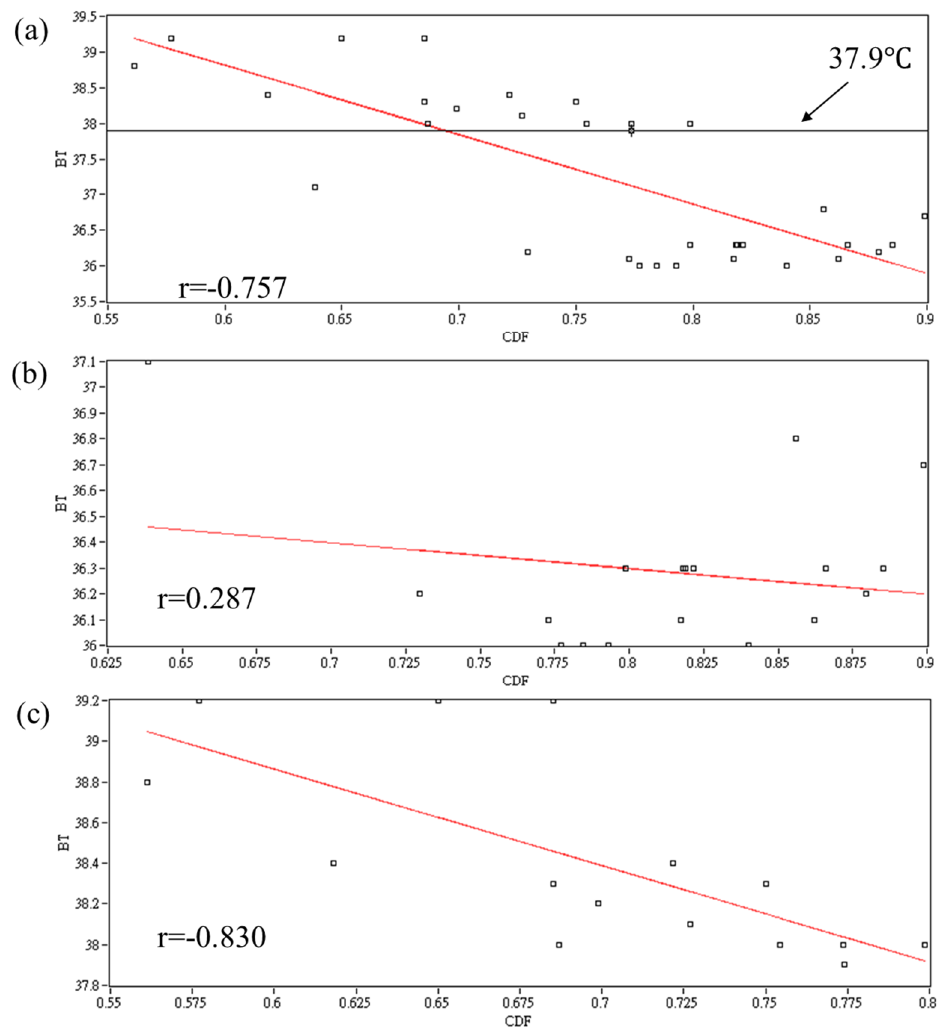
Figure 4. Linear fitting and Spearman r value between body temperature and CDF(E( k = 19)) of iPR in ( a ) total subjects; ( b ) non-fever group; ( c ) Fever group.